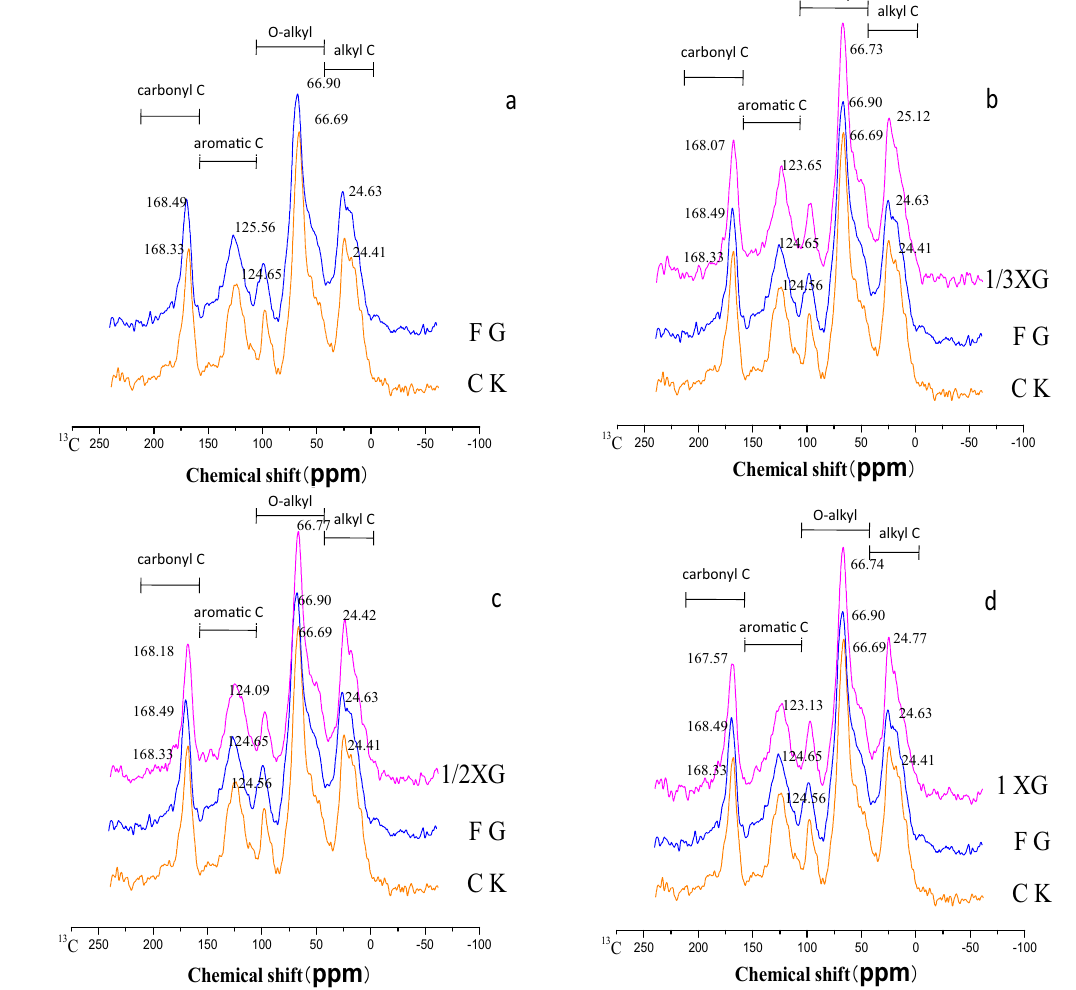
Figure 2. CPMAS 13 C-NMR spectra of organic carbon in Black soil treated with different straw returning treatments. CK control (stubble remaining in soil), FG full straw mulching, 1 XG full straw returning combined with rotary tillage, 1/2 XG 1/2 of full straw returning combined with rotary tillage, 1/3 XG 1/3 of full straw returning combined with rotary tillage. ( a ) The comparison of FG with CK; ( b ) the comparison among 1/3 XG, FG, and CK; ( c ) is the comparison among 1/2 XG, FG, and CK; ( d ) is the comparison among XG, FG, and CK.